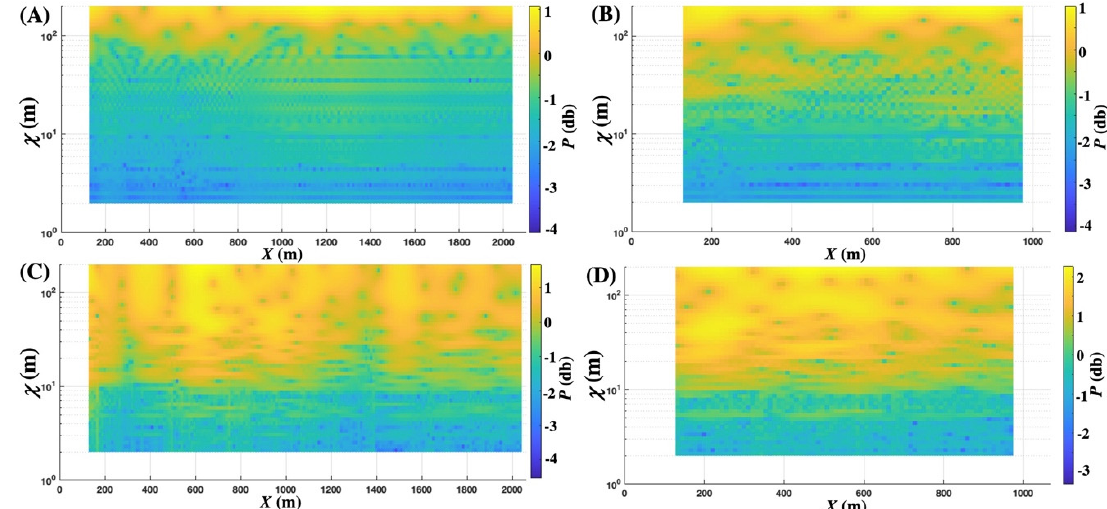
Figure 11. Power, P , spectrograms for sea surface background temperature of length scale, χ , versus along-slick distance, X , for ( A ) 23 May 2016 and ( B ) 25 May 2016 and χ for oil streamer along-slick linear mass, β , versus X for ( C ) 23 May 20161 and ( D ) 25 May 2016. Data keys on panels.